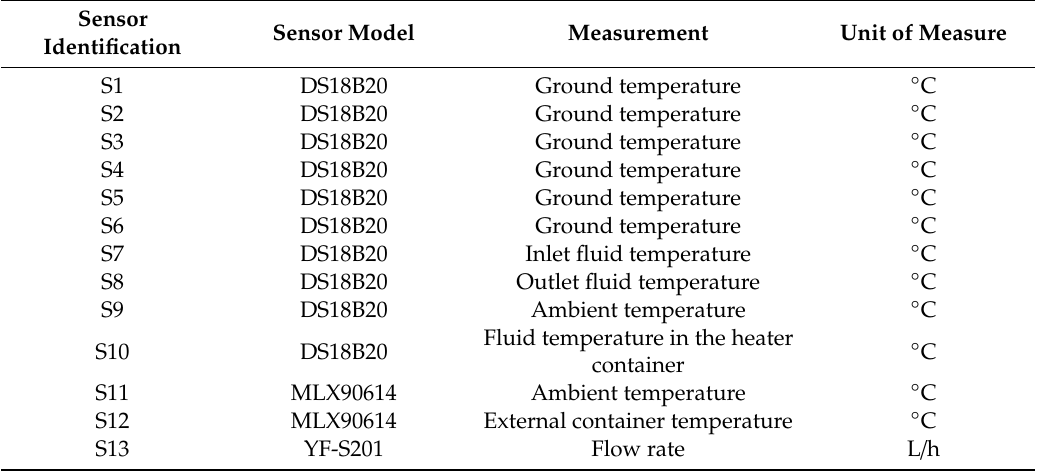
Table 1. Description of the temperature sensors used in the experimental